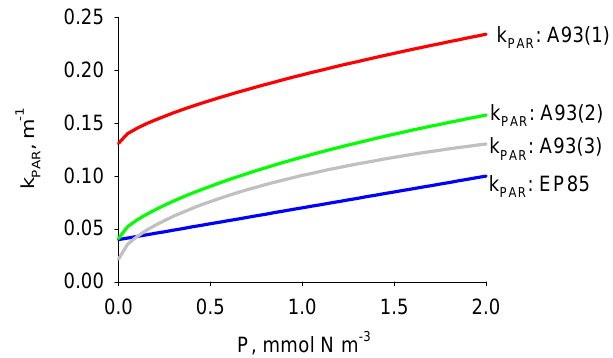
Figure 19. Light attenuation as predicted by Evans and Parslow (1985; EP85) and for the three layers (0–5, 5–23, > 23m; 1 , 2 , 3 re- spectively) in Anderson (1993; A93), as a function of phytoplankton concentration.